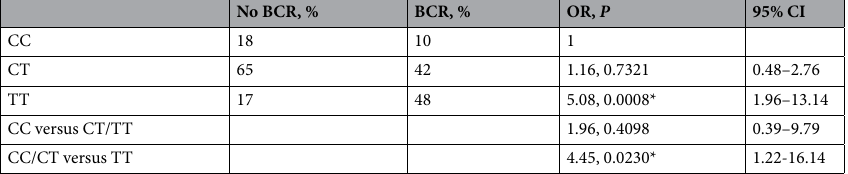
Table 5. Association of 17p12 rs4054823 with BCR. BCR: biochemical recurrence. OR: odds ratio. CI: confidence interval. * Significant difference at P <